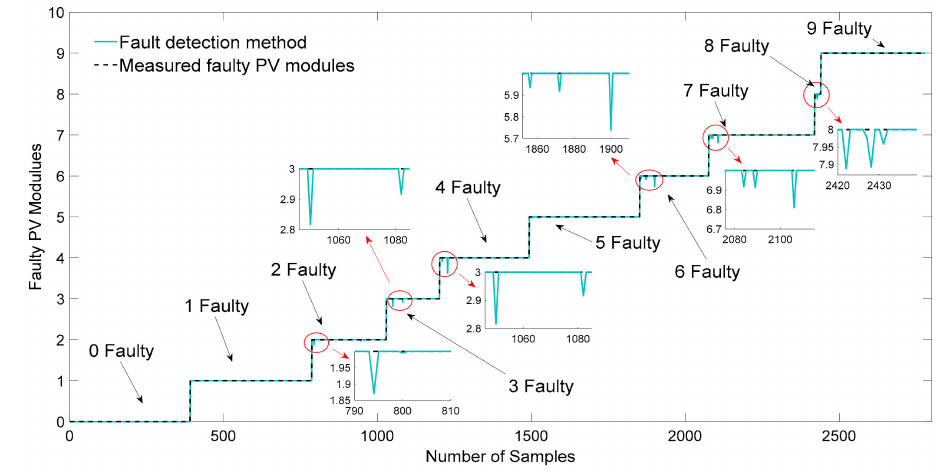
Figure 16. System 1 results using the neuro-fuzzy proposed method.